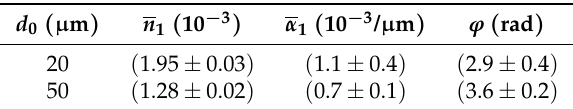
Table 1. Fitting parameters obtained from 2BC data at λ r = 355 nm and t p = 12 s for thin samples. The thickness was taken from the fit to the angular dependence of the diffraction efficiency (see Section